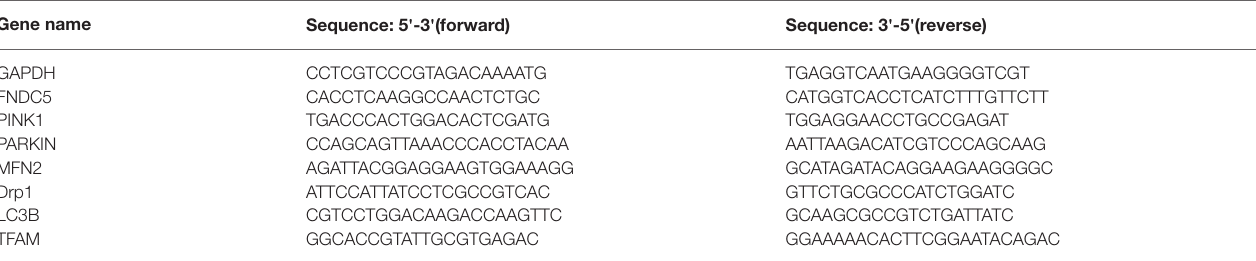
TABLE 1 | PCR primer